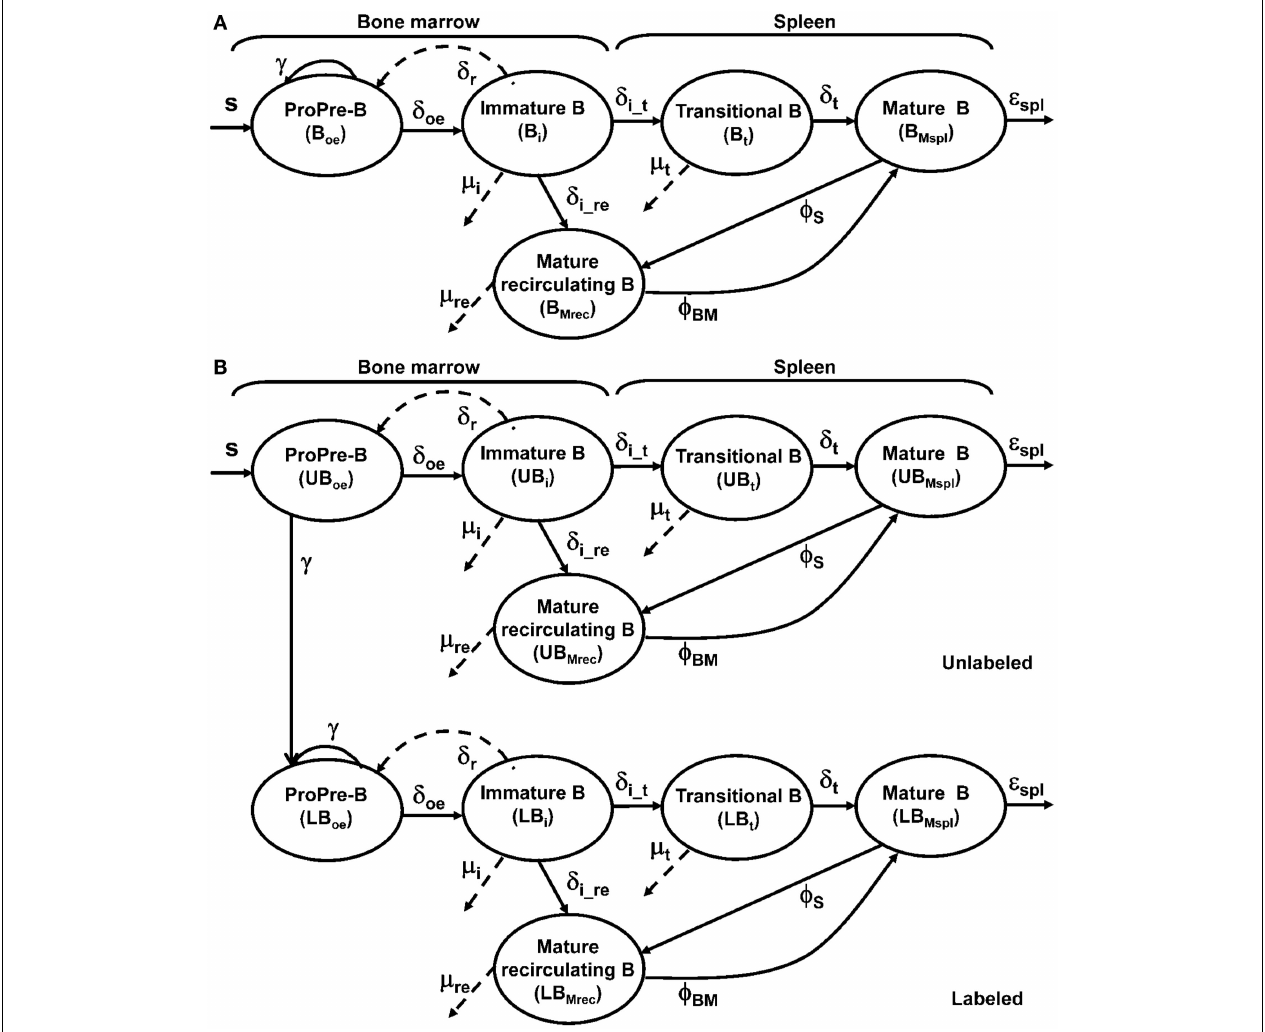
FIGURE 1 | Model of B cell population dynamics in the bone marrow and spleen . (A) The model of maturing B-cell population dynamics in the bone marrow and spleen is shown. All population processes – differentiation, proliferation, and death – are described by arrows. The rate of each process is given near the corresponding arrow. S is the source of B lineage precursors (cells/6h), parameters δ denote differentiation rates, μ mortality rates, γ proliferation rates, and φ flow rates. (B) The model for labeling dynamics of developing B cells in the bone marrow assumes that cells in the unlabeled pro-/pre-B cell compartment move to the corresponding labeled compartment upon dividing. The model also assumes that each labeled cell remains labeled for the duration of the